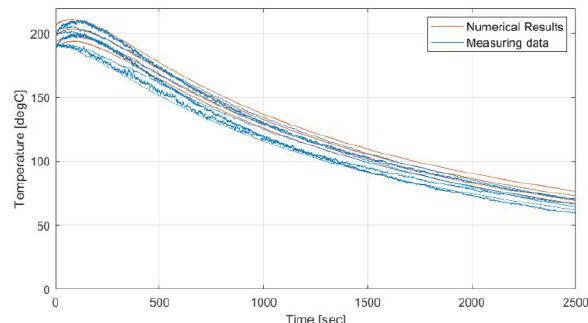
Fig. 17. Comparing the experimental and numerical results on case tube